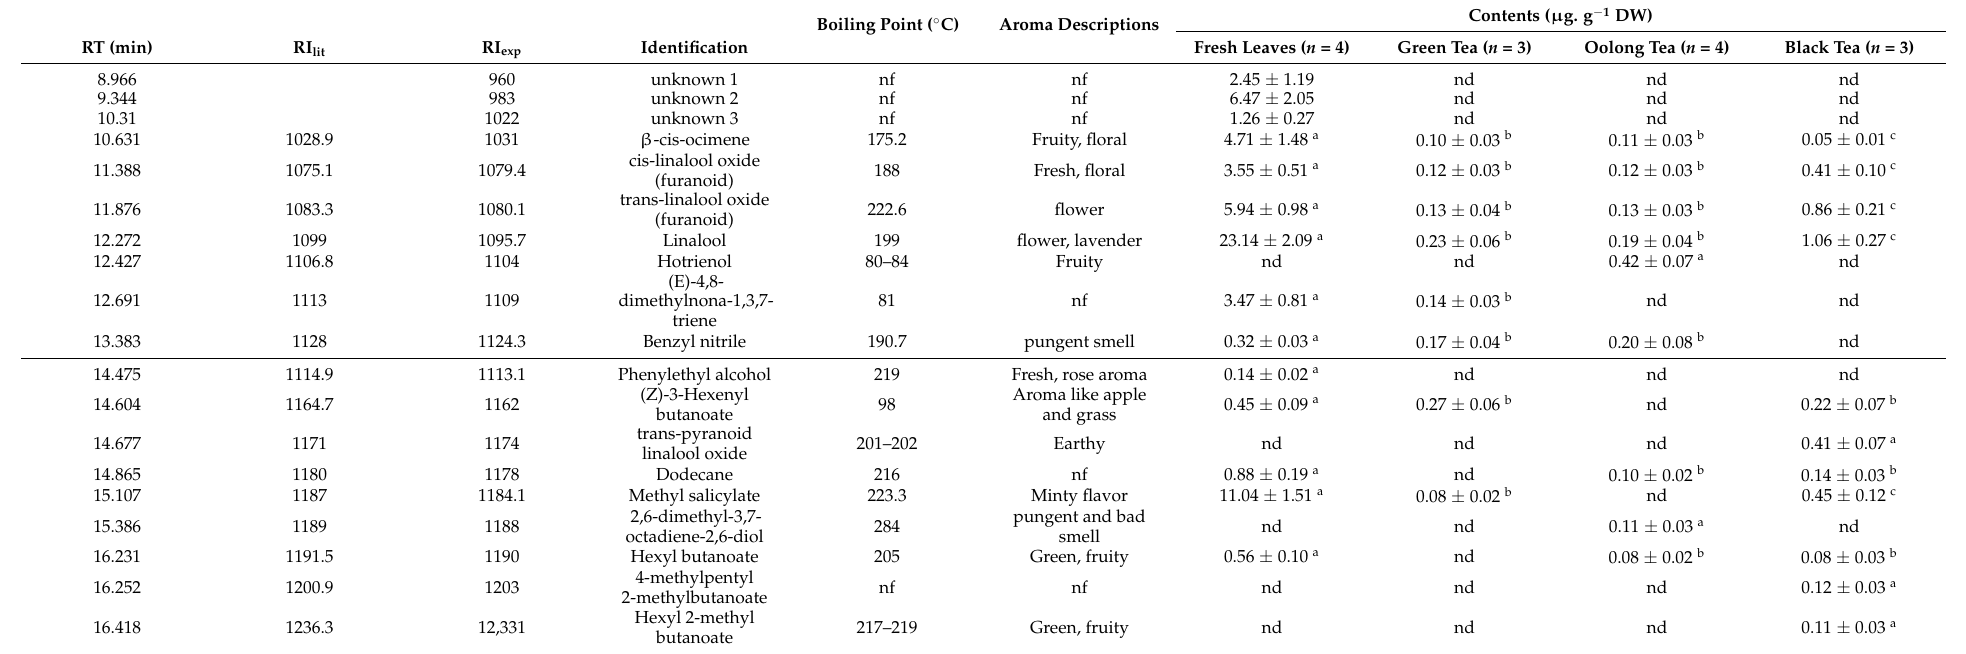
Table 1. Volatile contents from fresh tea leaves, green tea, oolong tea, and black